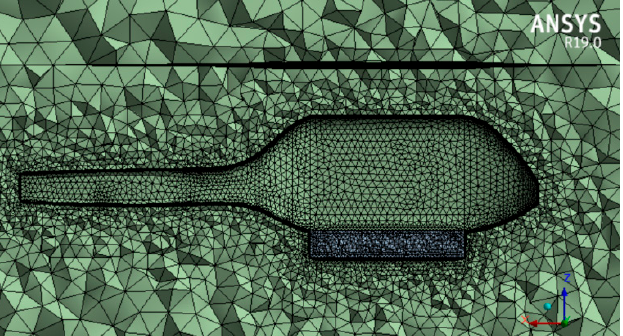
Figure 5. Meshes near the helicopter and tank on a longitudinal symmetric plan of the computational domain (there are boundary-layer meshes on the fuselage surface, the external tank surface, and both sides of the blade disc).